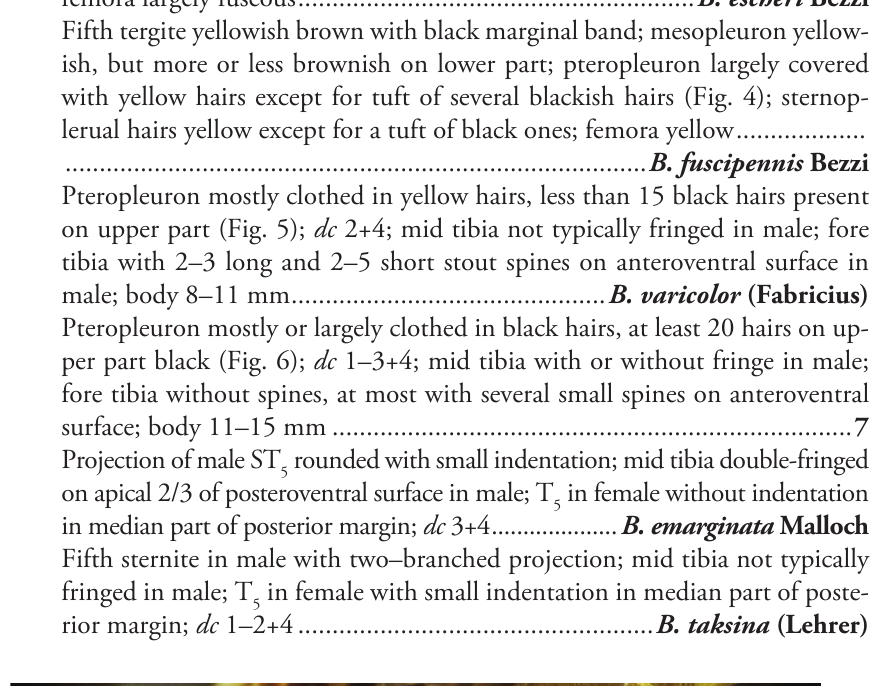
7 Projection of male ST rounded with small indentation; mid tibia double-fringed 5 on apical 2/3 of posteroventral surface in male; T in female without indentation 5